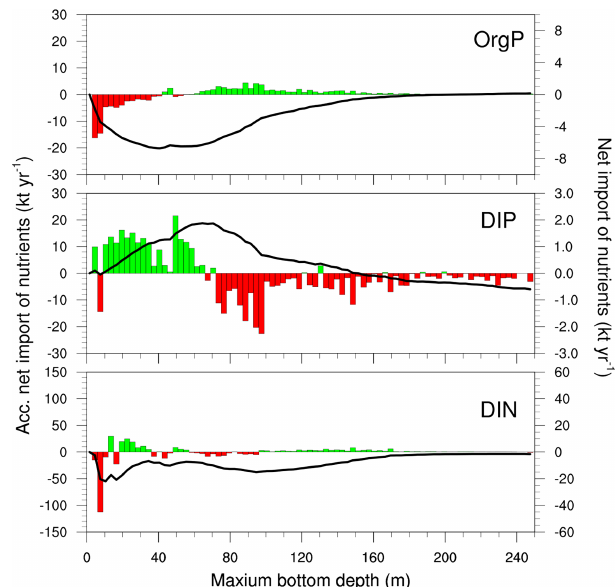
Figure 9. Annual mean, accumulated net imports (black lines), and imports of OrgP, DIP and DIN (color bars) to regions with the same depth in the Baltic proper averaged for the period 1970–1999.